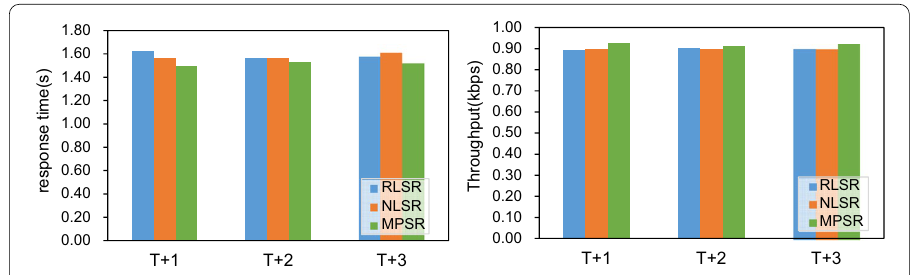
Fig. 5 Impact of different recommending strategies on